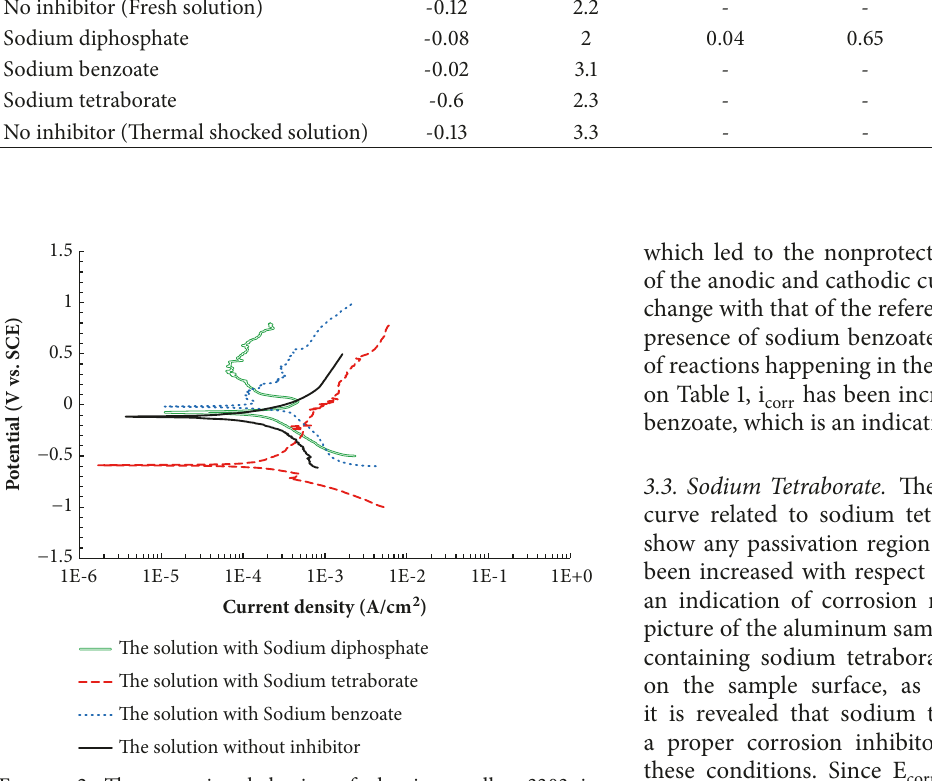
Figure 2: The corrosion behavior of aluminum alloy 3303 in galvanic coupling state with five other metals in different